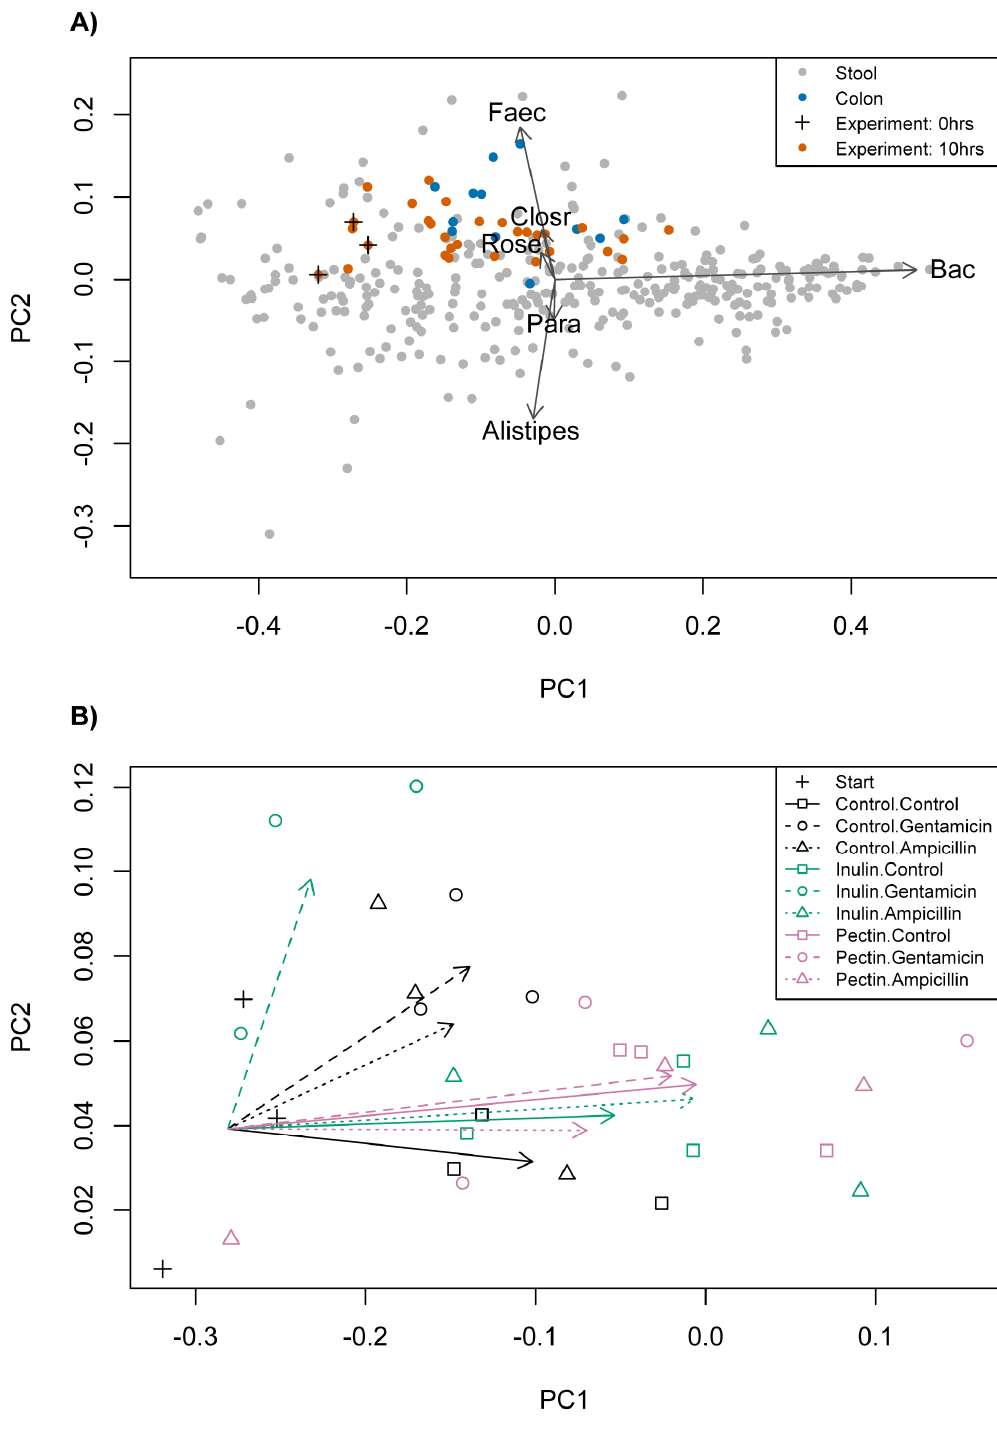
Figure 1 . ( A ) The first two principal components representing variation in frequencies of common genera across Human Microbiome Project samples (grey), stool samples from Stearns et al. [35] (also grey), colon samples from Stearns et al. [35] (blue), our starting cultures (marked by +) and our time 10 experimental samples (orange). Correlations with six main genera are shown. ( B ) An expanded plot focusing on our experimental samples, with arrows showing the change in mean values of principal component 1 (PC1) and principal component 2 (PC2) in each experimental treatment. Faecalibacterium (Faec), Clostridium (Closr), Roseburia (Rose), Bacteroides (Bac), Parabacteroides